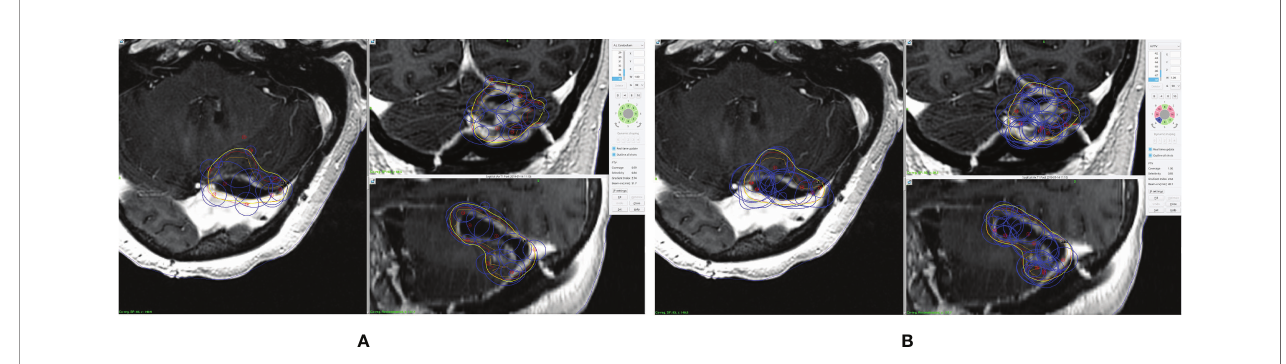
FIGURE 1 | An example of prescription dose coverage and shot placement in (A) clinical plan and (B) inversely optimized plan. The surgical cavity is delineated in orange, and the CTV is in red. The blue lines represent the shots, and the yellow lines represent the isodose lines of the prescription